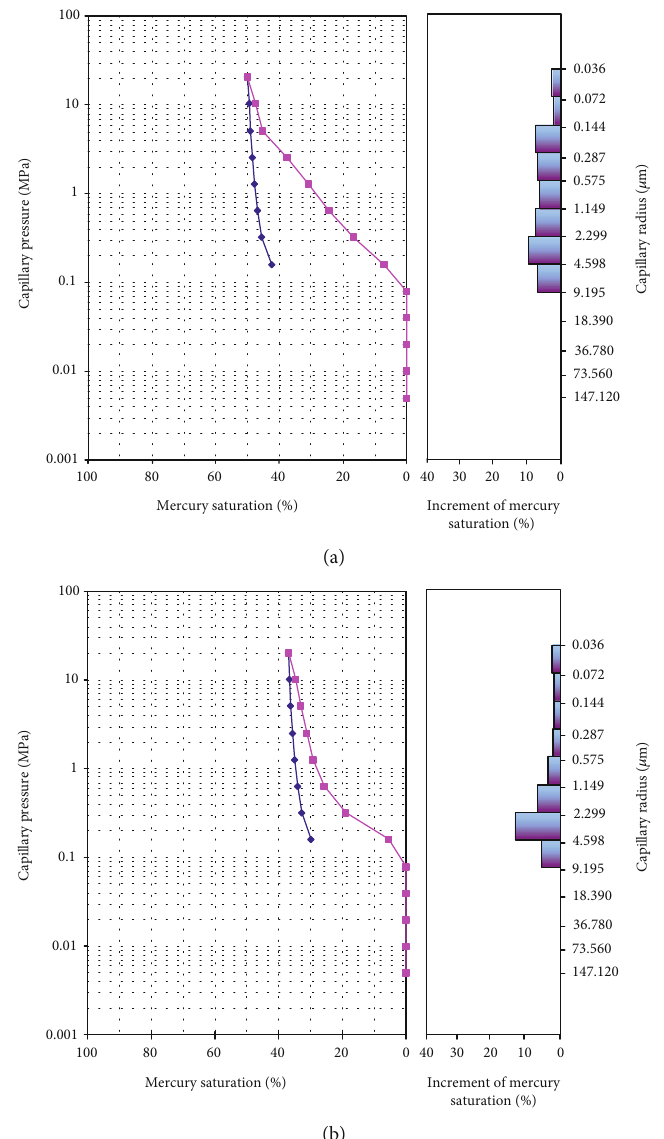
Figure 3: Capillary pressure curve and pore-throat distribution histogram of mercury deposits in the second member of the Wu 2 section in the Ke017 well